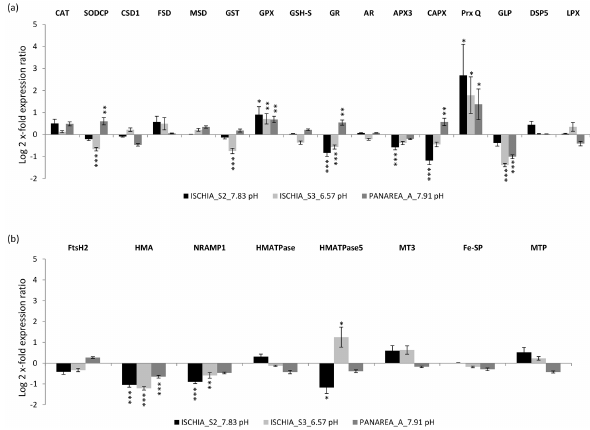
Figure 2. Expression levels of P. oceanica antioxidant (a) and heavy-metal-related genes (b) from plants collected at Ischia (S2 and S3 sites with pH 7.83 and 6.57) in relation to the control site (pH 8.14), and at Panarea (pH 7.91) in relation to its control site (pH 8.17). Control sites are represented by x